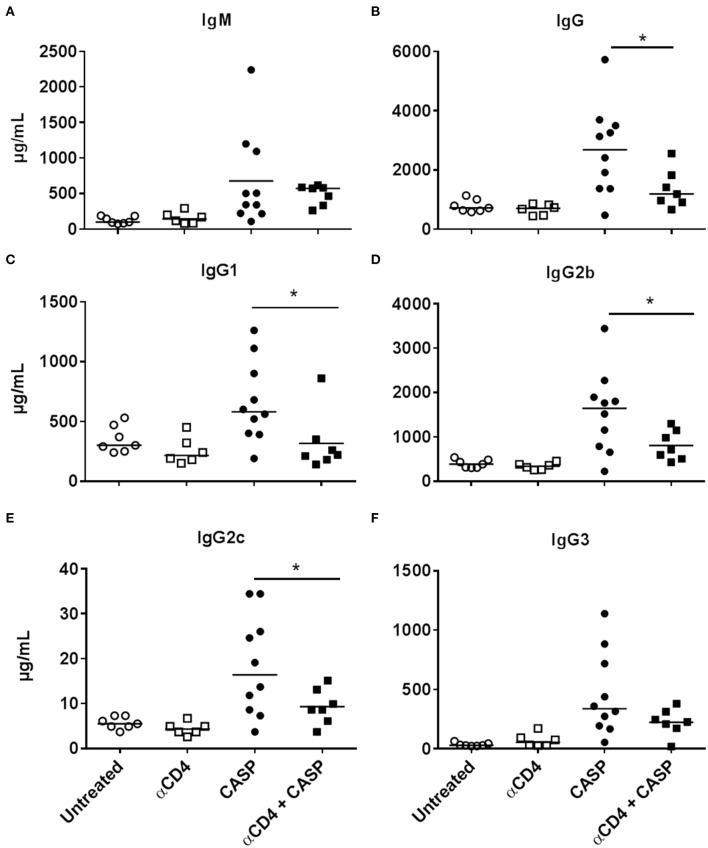
Serum Ig concentration 14 days after CASP and CD4+ cell depletion. Female C57BL/6 mice received 150 μg of a depleting anti-CD4 antibody (αCD4; Gk1.5) i.p. three and one day before sepsis induction via CASP. Control animals remained untreated or received the depleting antibody only. Fourteen days after CASP, animals were anesthetized and blood was collected. IgM (A) and IgG (B) serum concentrations, as well as IgG subclass concentrations (C–F), were measured by Luminex®-technology. Shown is the mean of the collective data from two independent experiments with a similar tendency. We used the One Way ANOVA and Bonferroni post-hoc test for selected pairs for statistical evaluation *p < 0.05. N = 6–10 per group.